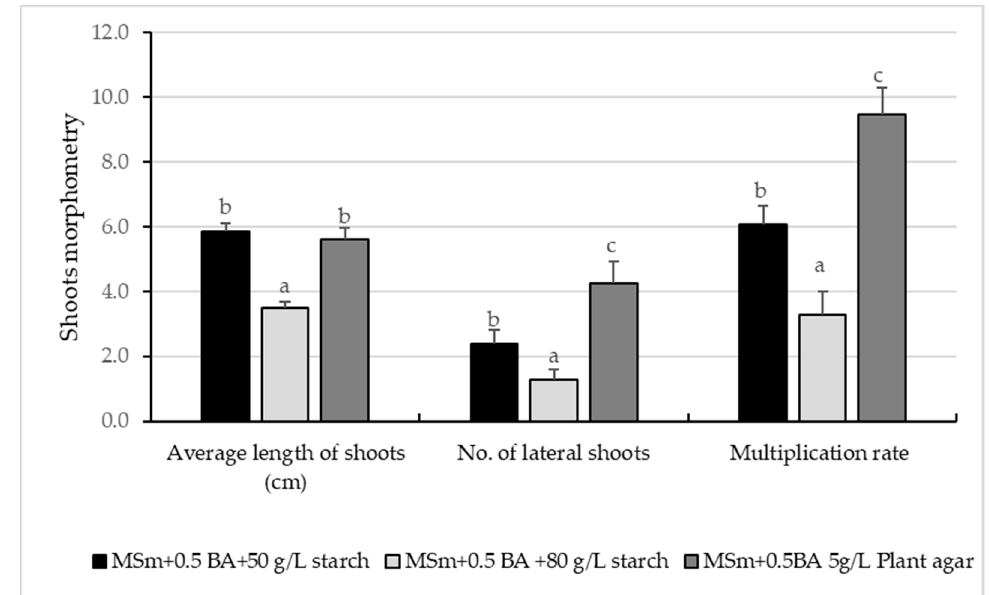
Figure 2. Influence of Plant agar and wheat starch on shoots’ proliferation in H. lupulus cv. Cascade. Different lowercase letters above the bars indicate significant differences between the means of the same parameter according to Tukey’s HSD test ( p < 0.05).